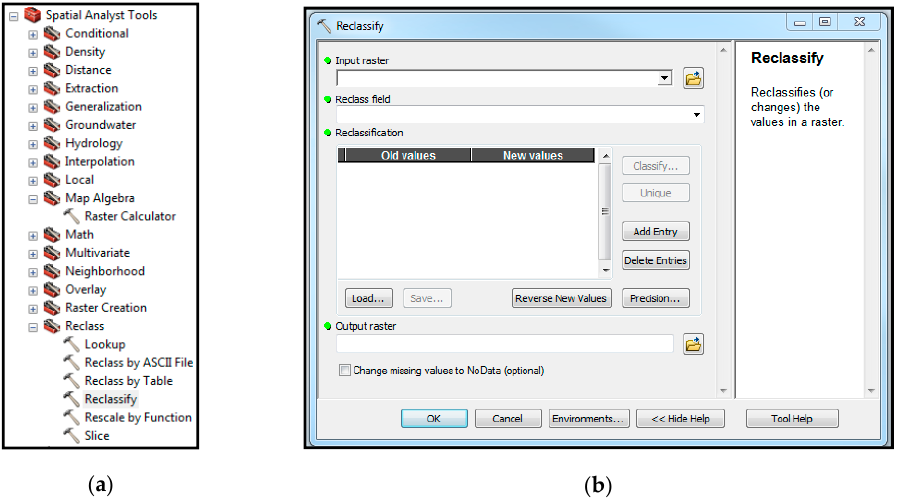
Figure 10. Reclassify tool within ArcMap/GIS: ( a ) Reclassify tool; ( b ) reclassify window.